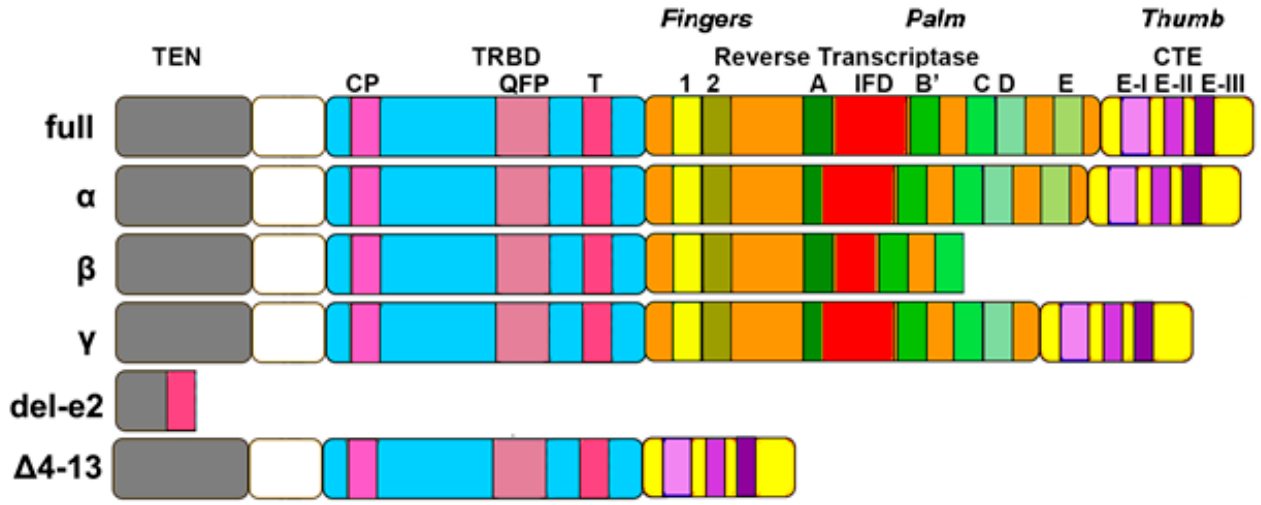
Figure 2. Architecture of of human TERT and alternative isoforms. TEN: telomerase essential N- terminal domain; TRBD: telomerase RNA binding domain; CTE: C-terminal extension. Isoform α shows a partial loss of Reverse Transcriptase-motif A. Isoform β shows partial loss and sequence variation of the IFD domain, as well as loss of the D and E fingers motifs and CTE domain. Isoform γ is similar to α , but also shows the loss of the E finger motif. Del-e2 is composed only of part of the TEN domain and T-motif.